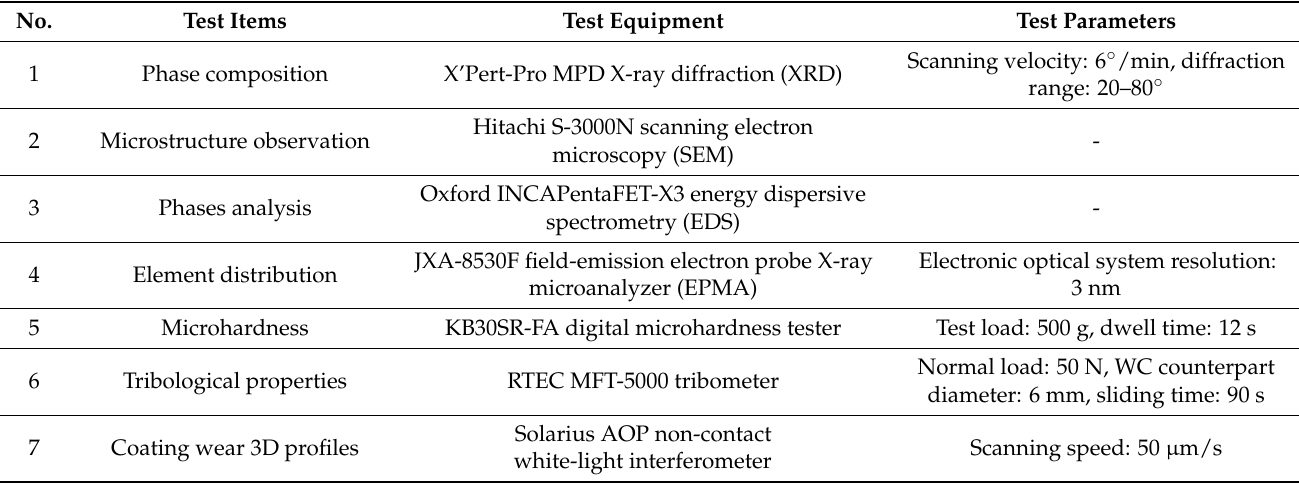
Table 4. The test equipment and test